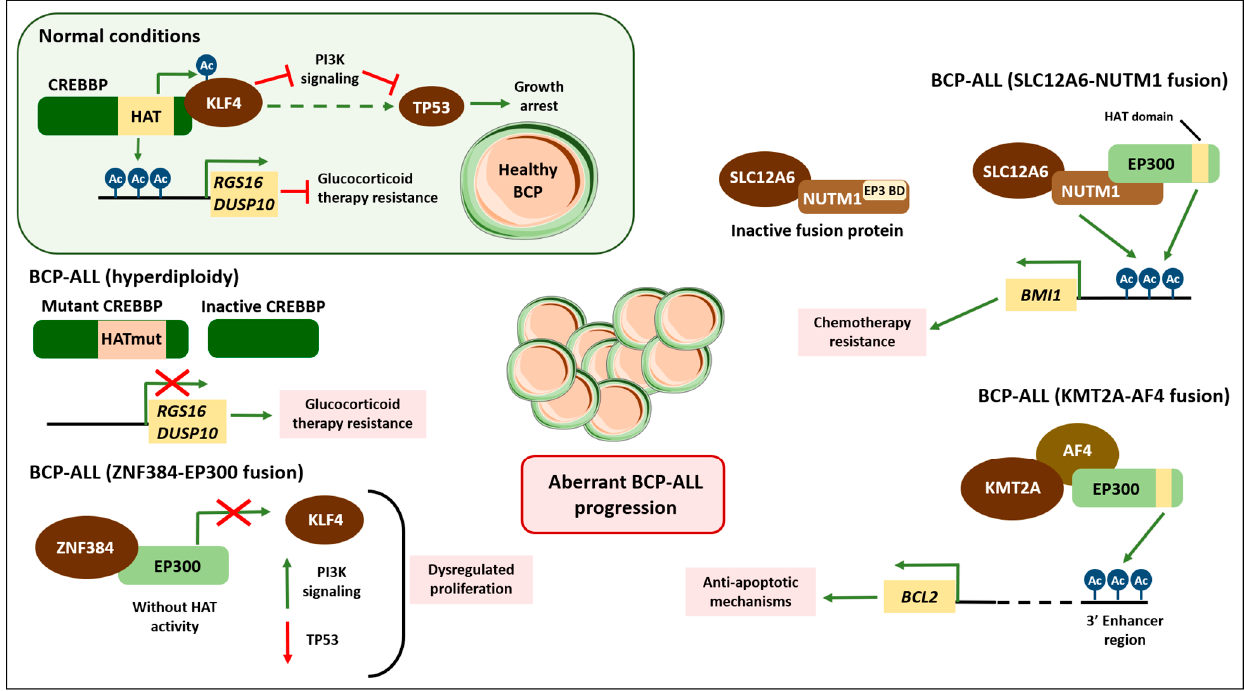
Figure 2. Alterations of histone acetylases drive aberrant BCP-ALL progression. Histone acetylase CREBBP and its homolog EP300 are involved in driving progression of distinct subtypes of BCP-ALL, which displayed the following alterations: ZNF384 - EP300 , SLC12A6 - NUTM1 and KMT2A - AF4 fusions and hyperdiploid BCP-ALL. Inset displaying the role of CREBBP under healthy conditions is colored green. Green arrows indicate activation; red lines and crosses indicate repression. Red squares indicate processes that induce a poorer prognosis. Blue marks labeled “Ac” indicate global histone acetylation, while purple “Ac” marks indicate acetylation of H3K27 residue in the enhancer region of BCL2 (in the context of the KMT2A - AF4 gene rearrangement). EP3 BD refers to EP300 Binding Domain. The overexpression of some enzymes of the HDAC family (HDAC2, − 3, − 4, − 6, − 7, − 8, − 9, − 11) has been linked to an unfavorable prognosis and an impaired response to conven- tional glucocorticoid treatment in two studies [120,127]. However, these studies included